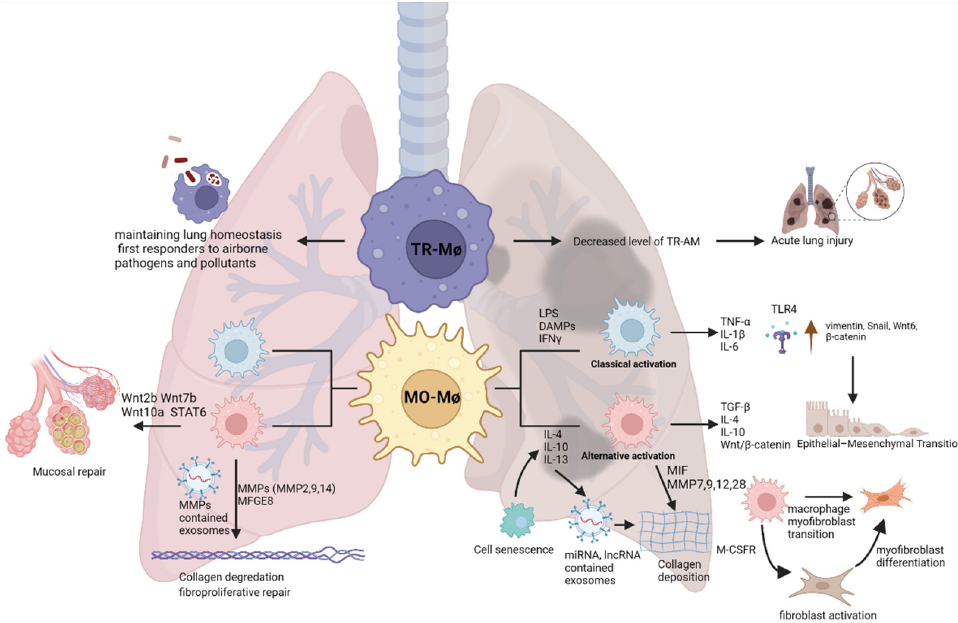
Figure 1. Schematic representation for hypothetical the role of alveolar macrophages in pulmonary fibrosis. The left side of the figure represents the how macrophages can clean the fibrotic foci and keep homeostasis, the right side shows macrophage-induced fibrosis.